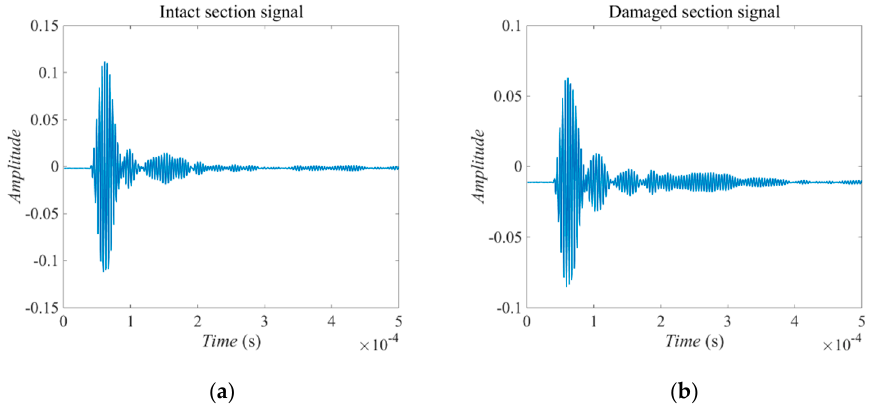
Figure 12. The received signals by piezoceramic transducers. ( a ) Signal at the intact section. ( b ) Signal at the damaged section.